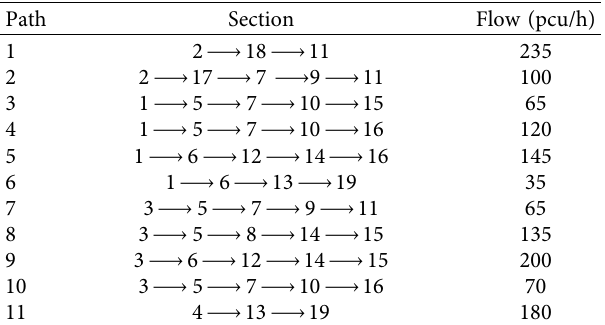
Table 3: Effective path sets and